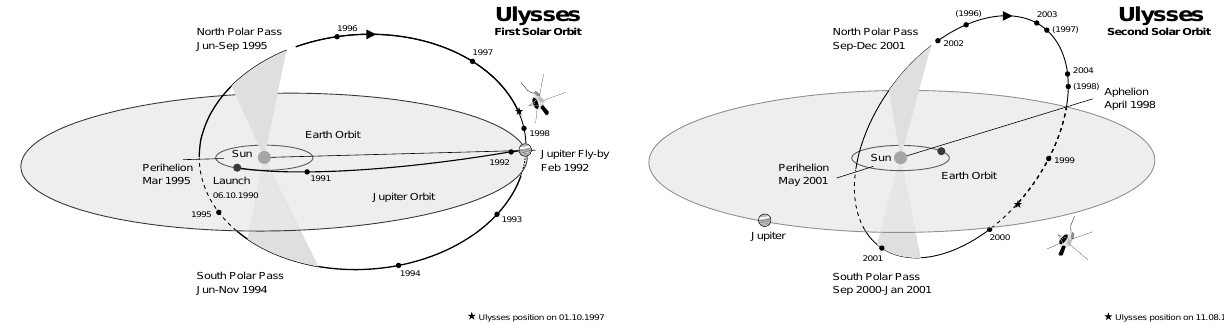
Fig. 1. Left: The first orbit of Ulysses around the Sun viewed from a perspective of 15 degrees above the ecliptic plane. The dots indicate the position of Ulysses at the beginning of each year. The Jupiter fly-by swung Ulysses out of the ecliptic and into a solar polar orbit. Right: The second orbit of Ulysses viewed from a perspective which shows the 80-degree inclination of the Ulysses orbit to the ecliptic. From http://helio.estec/esa/nl/Ulysses/Orbit.htm.